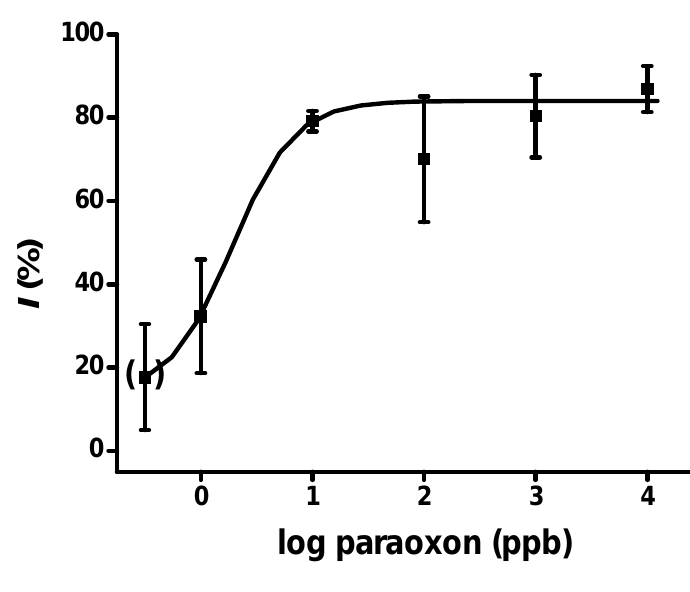
Figure 1. Calibration curve for paraoxon. Percentage of inhibition ( I ) vs. logarithm of paraoxon concentration (ppb) is presented. The error bars indicates standard deviation (n=3, where n is independent assay by a new